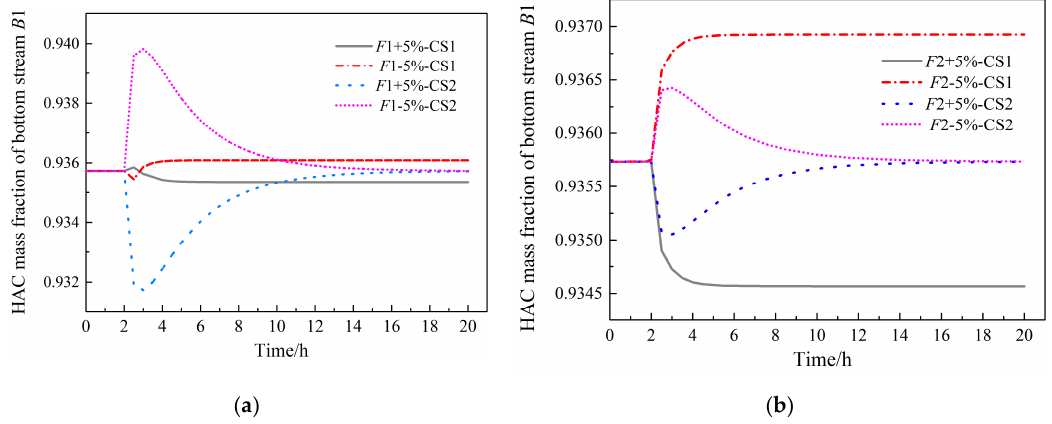
Figure 11. The control responses of CS1 and CS2 to the mass fraction on the HAc at the bottom. ( a ) Responses to disturbance in feed F1 and ( b ) responses to disturbance in feed F2.